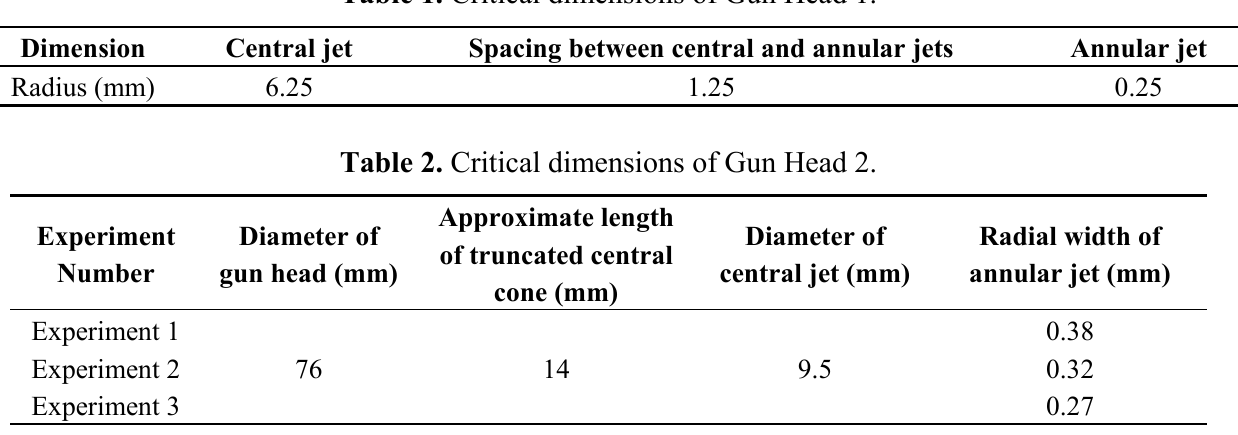
Table 1. Critical dimensions of Gun Head 1.